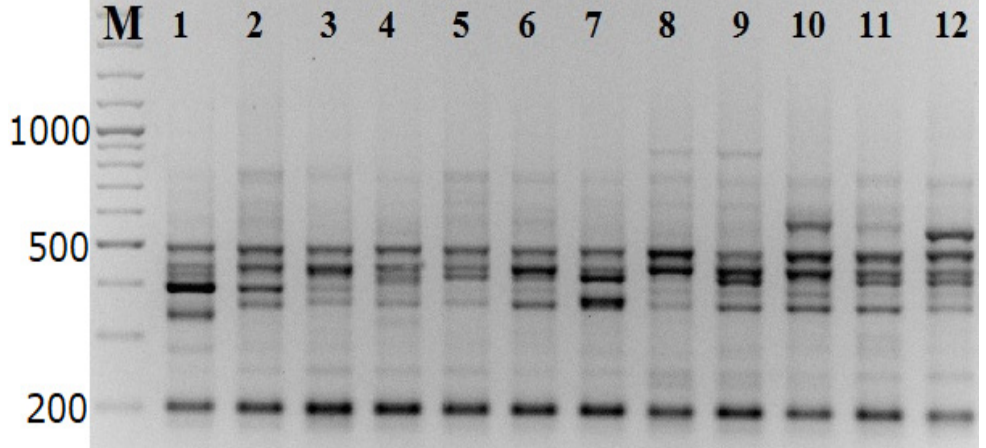
Figure 2. The band profiles with ISSR primer (X10) for the samples of P. sylvestris . The numbers on the top indicate the sample numbers. M: 100 bp DNA Ladder.